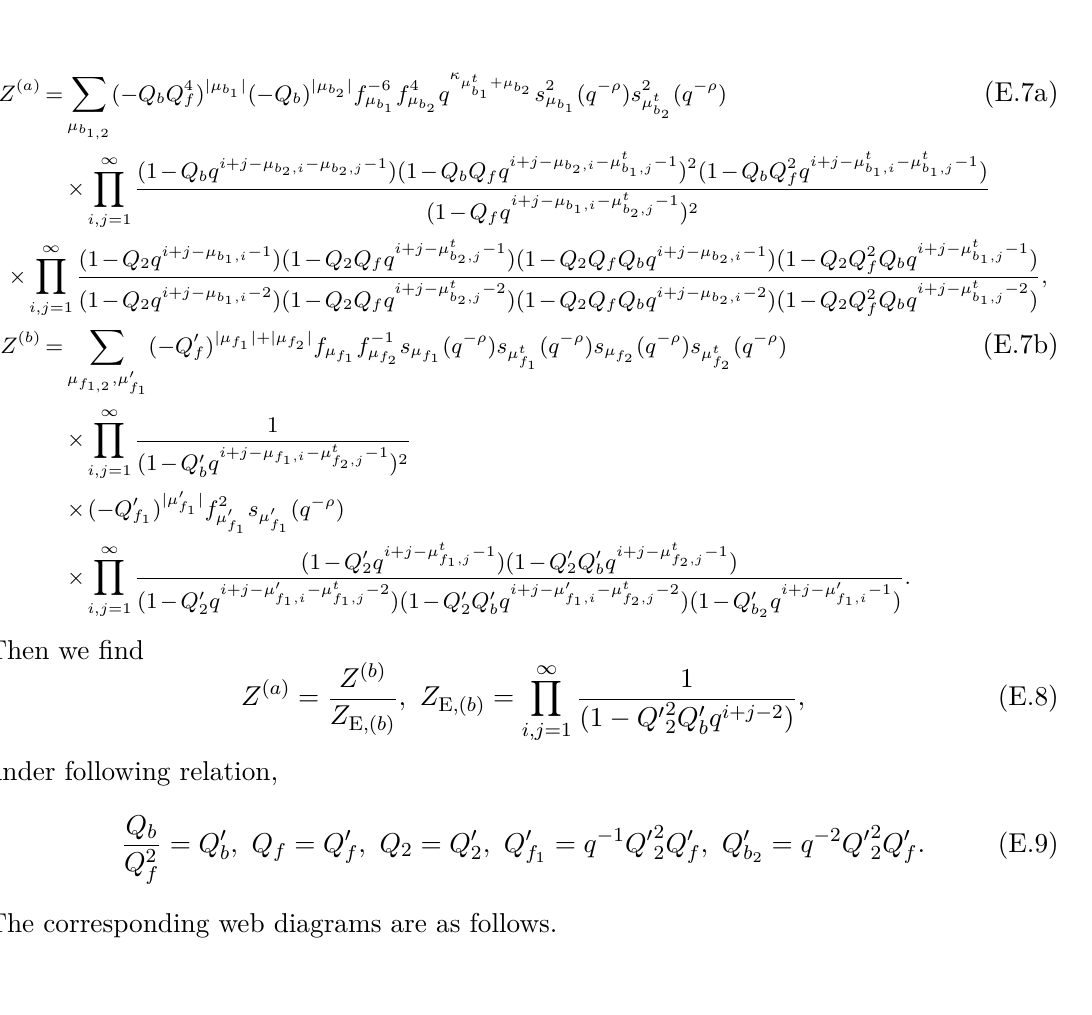
Figure 21 . The web diagrams which reduce to SU(2) gauge theory with θ = 4 π and θ = 0 in the presence of the defects after the geometric